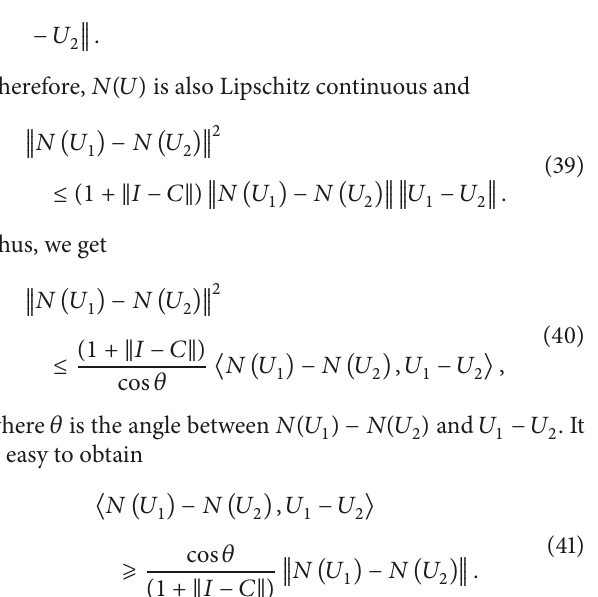
Table 1: Time complexity of GSNMF, GNMF, and NMF.